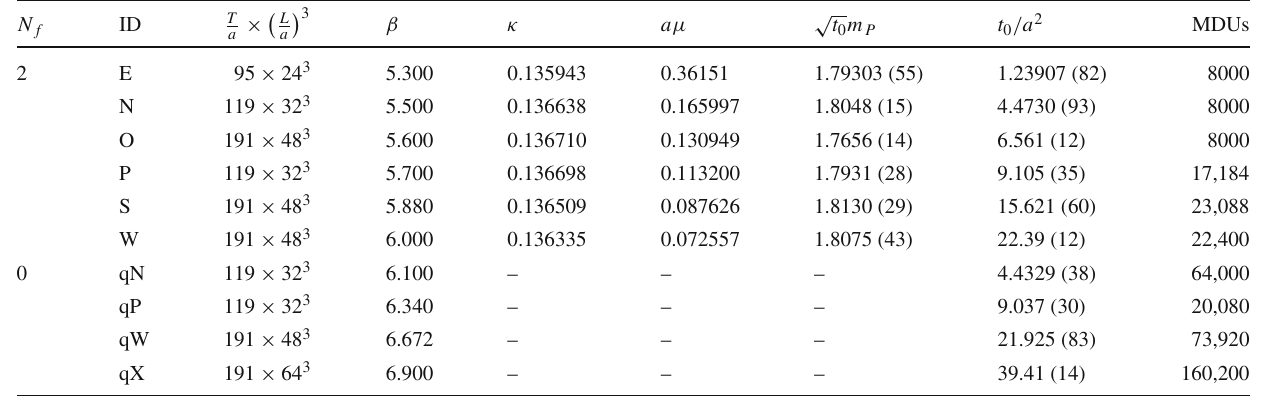
Table 1 Simulation parameters of our ensembles. The columns show in molecular dynamics units. Notice that even though the number of the lattice sizes, the gauge coupling β = 6 / g 2 , the critical hopping sites in the temporal direction is even, the temporal extent T is an odd 0 parameter, the twisted mass parameter μ , the pseudoscalar mass in t 0 multiple of a due to the open boundaries. The links pointing out of the units, the hadronic scale t 0 / a 2 defined in [40] and the total statistics lattice volume are